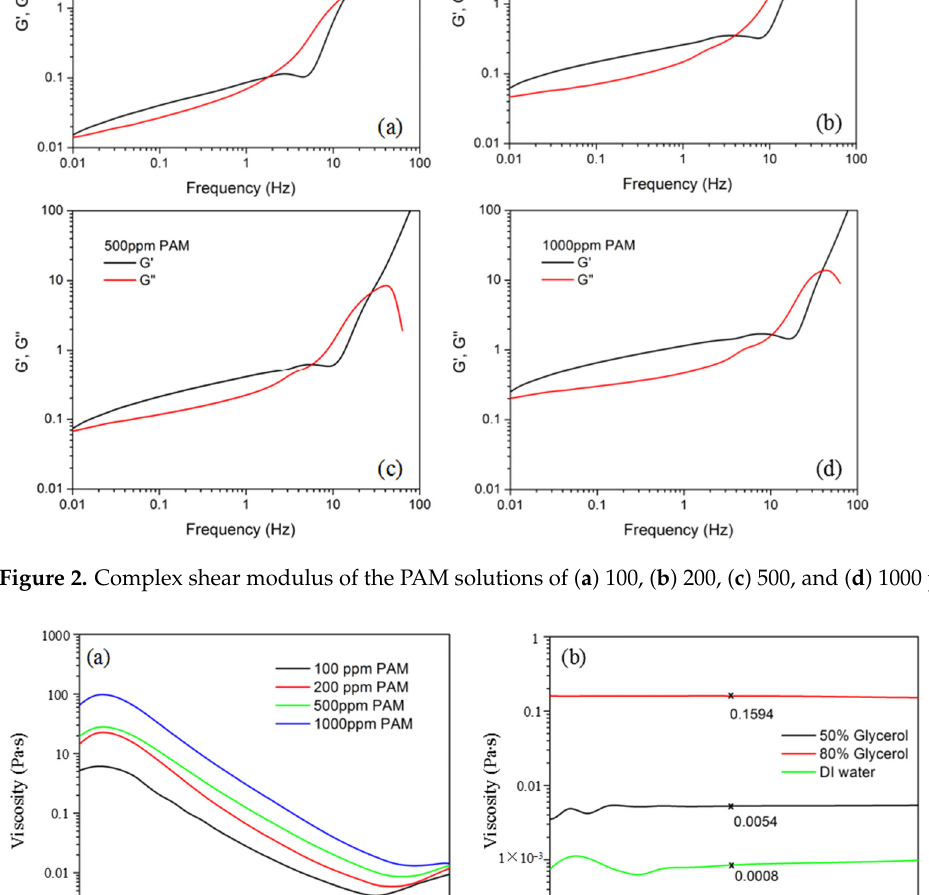
Figure 3. ( a ) Viscosity of non-Newtonian PAM solution and ( b ) Newtonian solutions.